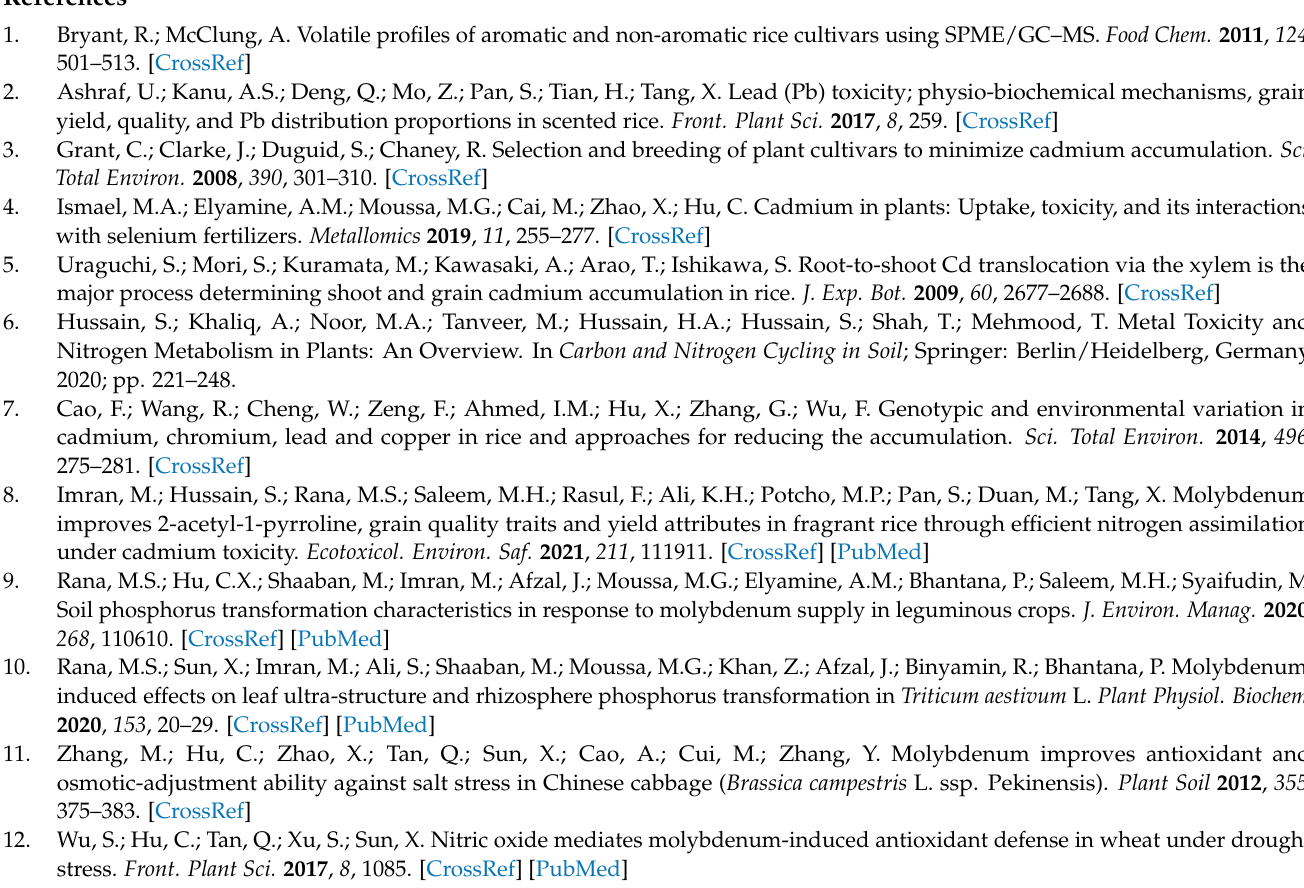
Table S2: Primer sequences used for qRT-PCR amplification, Table S3: Influence of